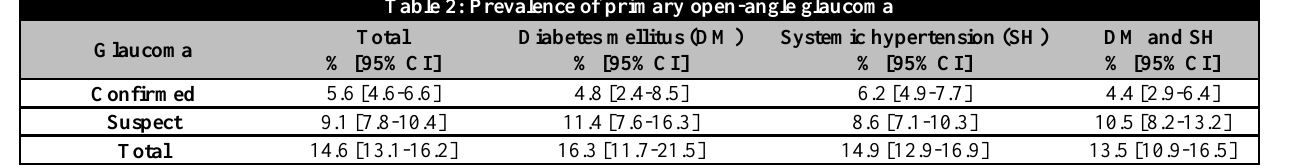
Table 2: Prevalence of primary open-angle glaucoma